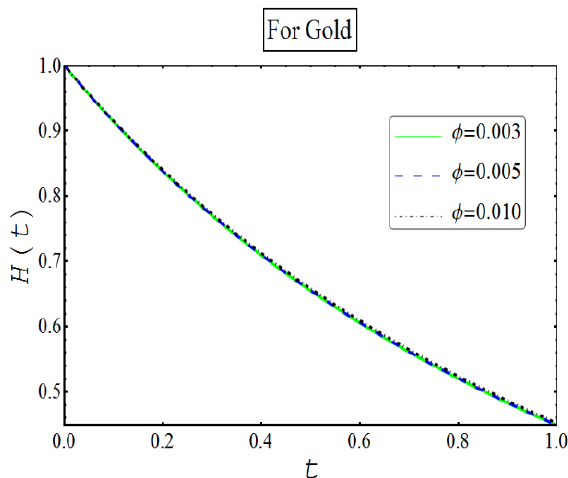
Figure 6. Effects of the concentration of particles on film thickness for the case of gold.